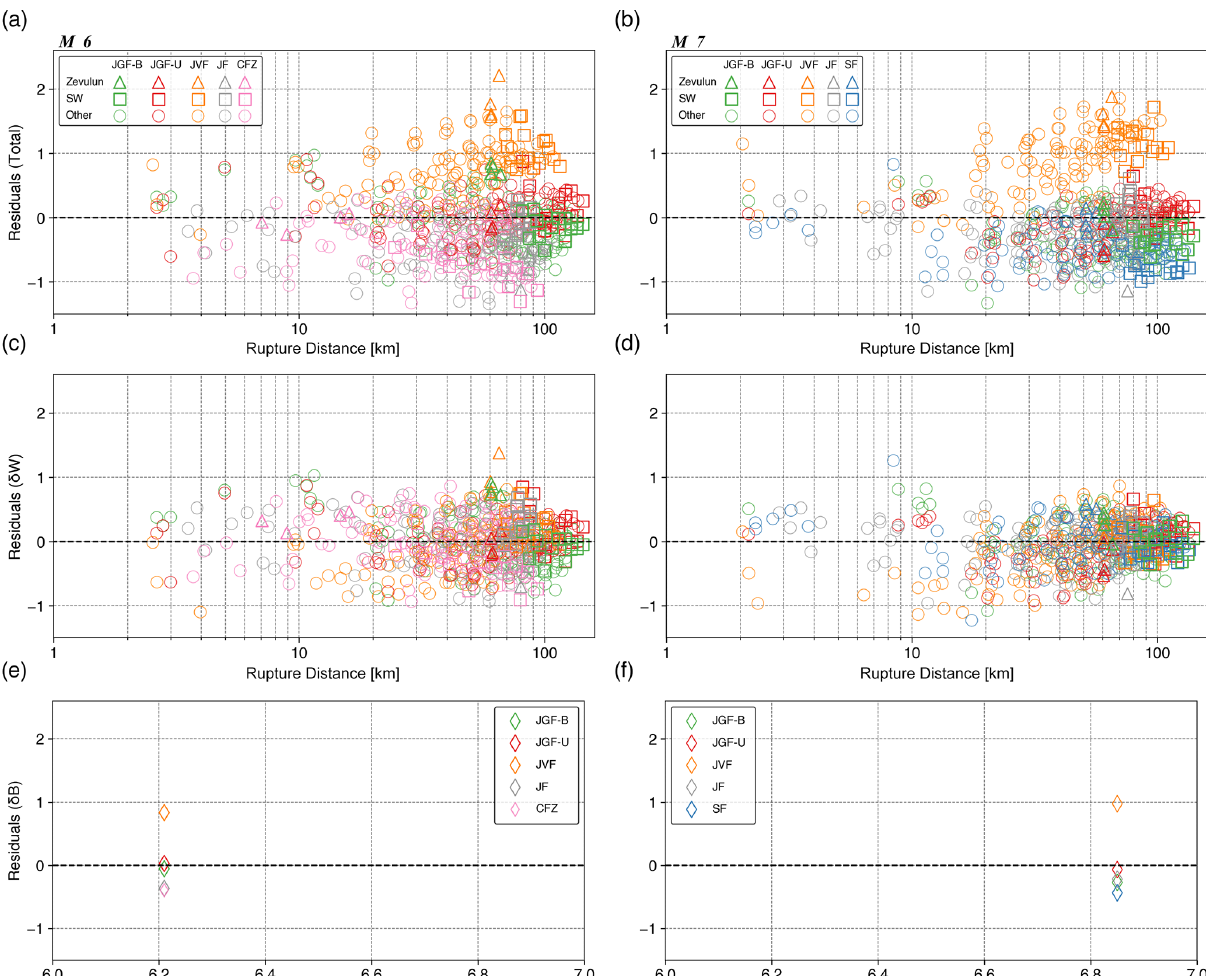
Figure 6. Residuals between simulated and attenuation model (AM) PGVs as a function of rupture distance ( R RUP ) for bilateral rupture on the Jordan Gorge Fault (JGF-B), Jericho Fault (JF), Carmel Fault Zone (CFZ; for M 6), and the Shemona Fault (SF; for M 7), a southward unilateral rupture on the JGF (JGF-U), and a super-shear rupture on the Jordan Valley Fault (JVF) for M 6 (left) and M 7 (right): (a, b) total residuals, (c, d) within-event ( δW ) residuals, and (e, f) between-event ( δB ) residuals. The records from Zevulun Valley and the sedimentary wedge (SW) are marked with triangles and rectangles, respectively. The other records are marked with circles. Residuals are in ln